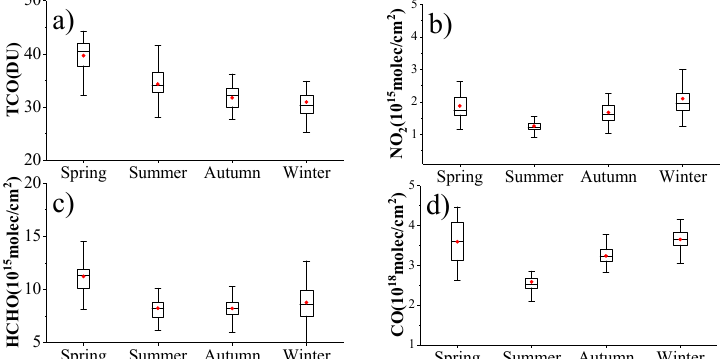
Figure 3. The seasonal boxplots of TCO ( a ), NO 2 ( b ), HCHO ( c ) and CO ( d ) (based on the 95% confidence interval of raw data present in Figure 2a).